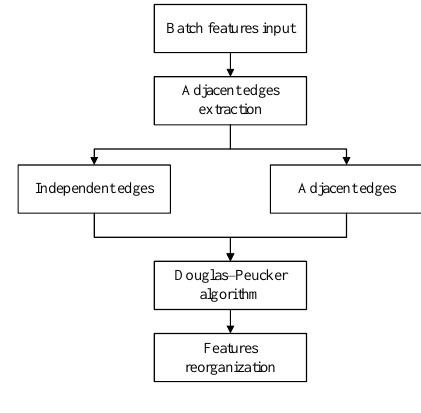
Figure 3. Vector data generalization